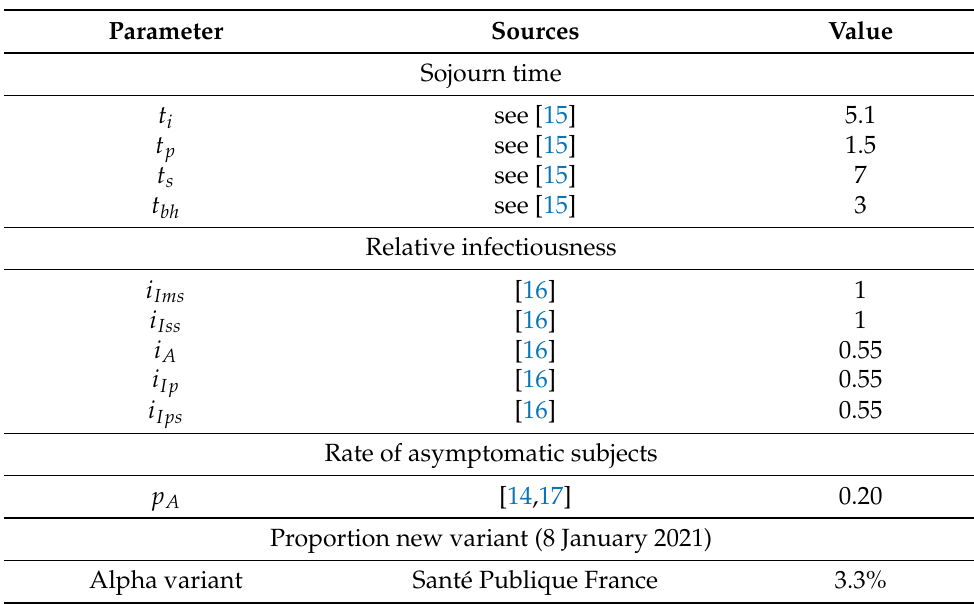
Table 7. Parameters sojourn time, relative infectiousness, and rate of asymptomatic subjects, as ob- tained from the